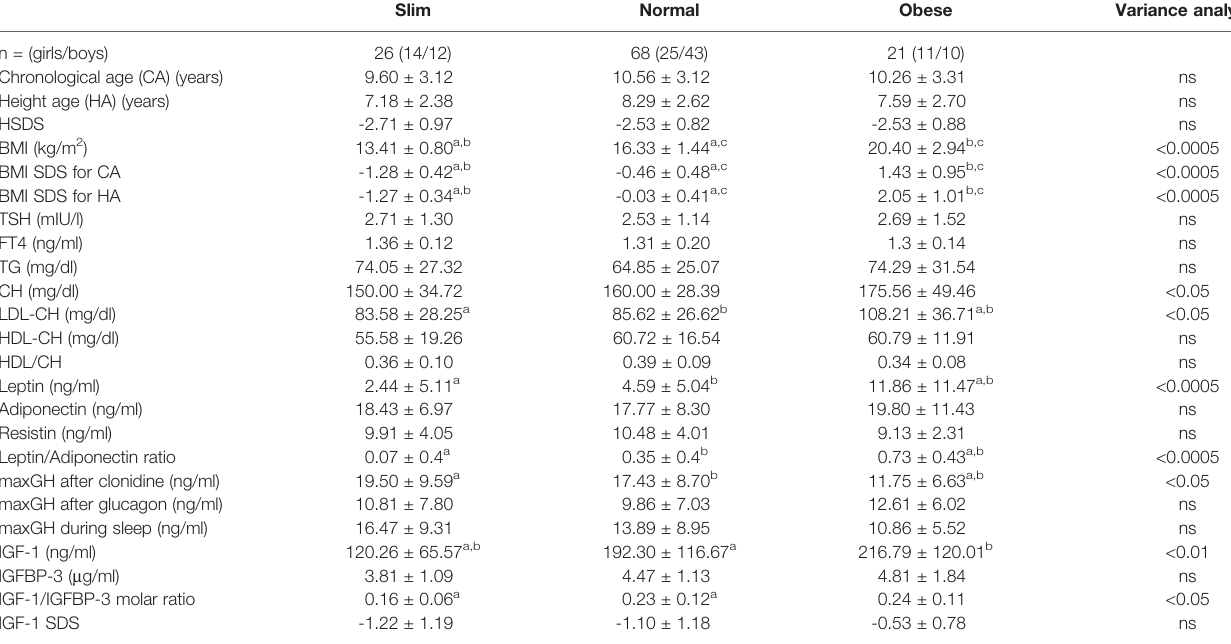
TABLE 1 | The results of analysed parameters in individual subgroups (slim, normal and obese) of ISS children. Slim Normal Obese Variance analysis